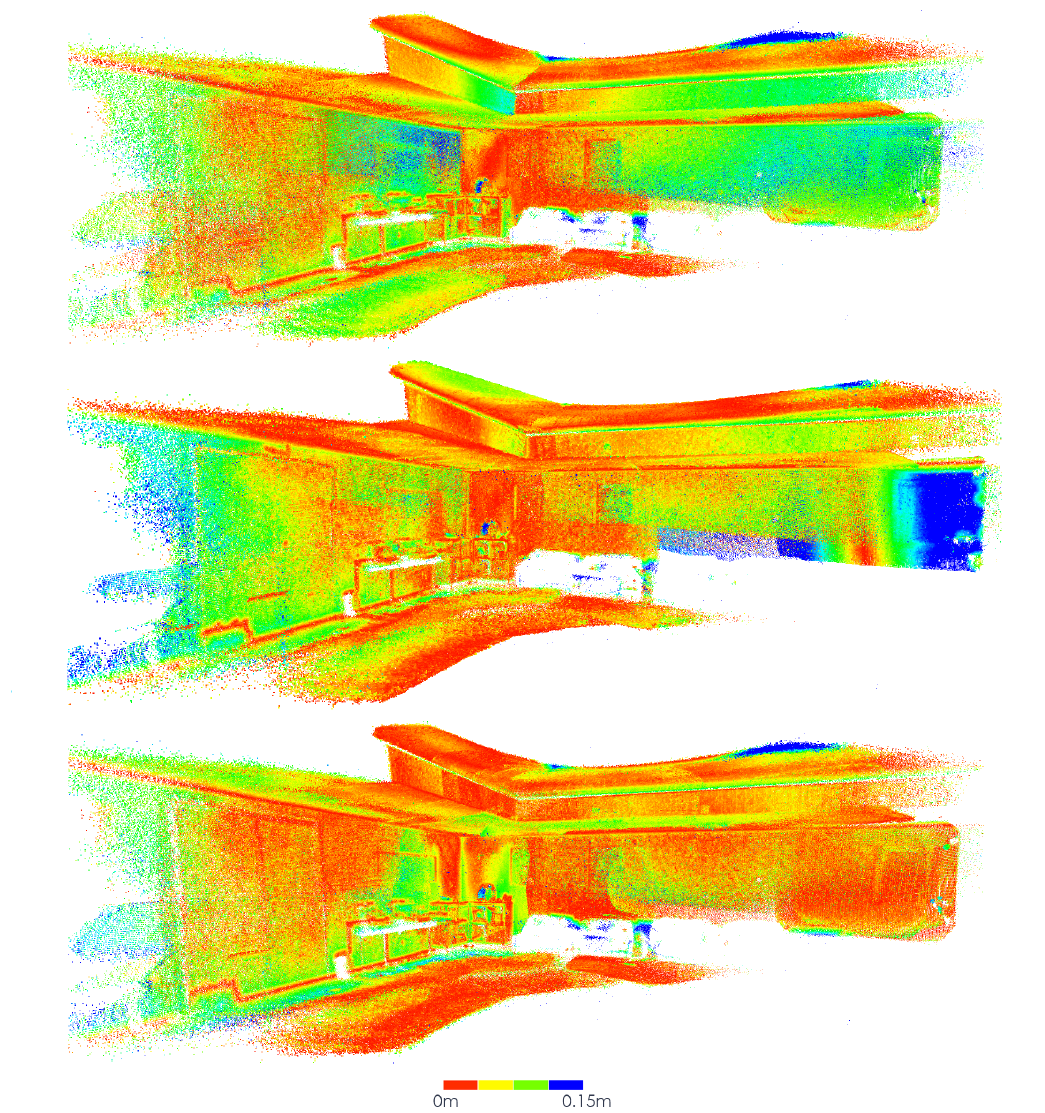
Figure 22. MeetingRoom dataset colourmapped with Hausdorff distance to FARO laser scanned point cloud: ( top ) Google Tango; ( middle ) ICP; ( bottom ) Our